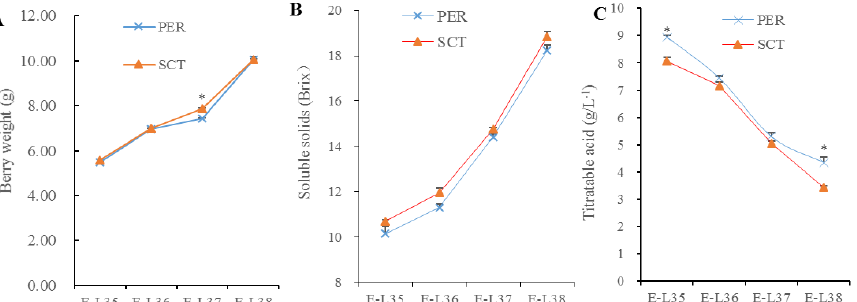
Figure 9. The effects of PER (pergola) and SCT (single-curtain training system) on berry weight ( A ),